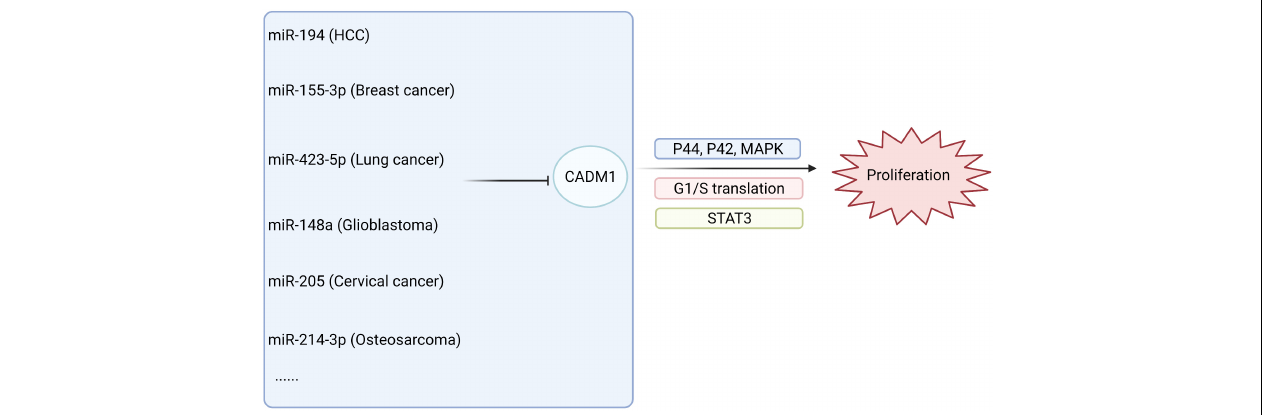
FIGURE 3 | MiRNAs are involved in the proliferation of malignant tumors by acting on CADM1 in multiple systems.